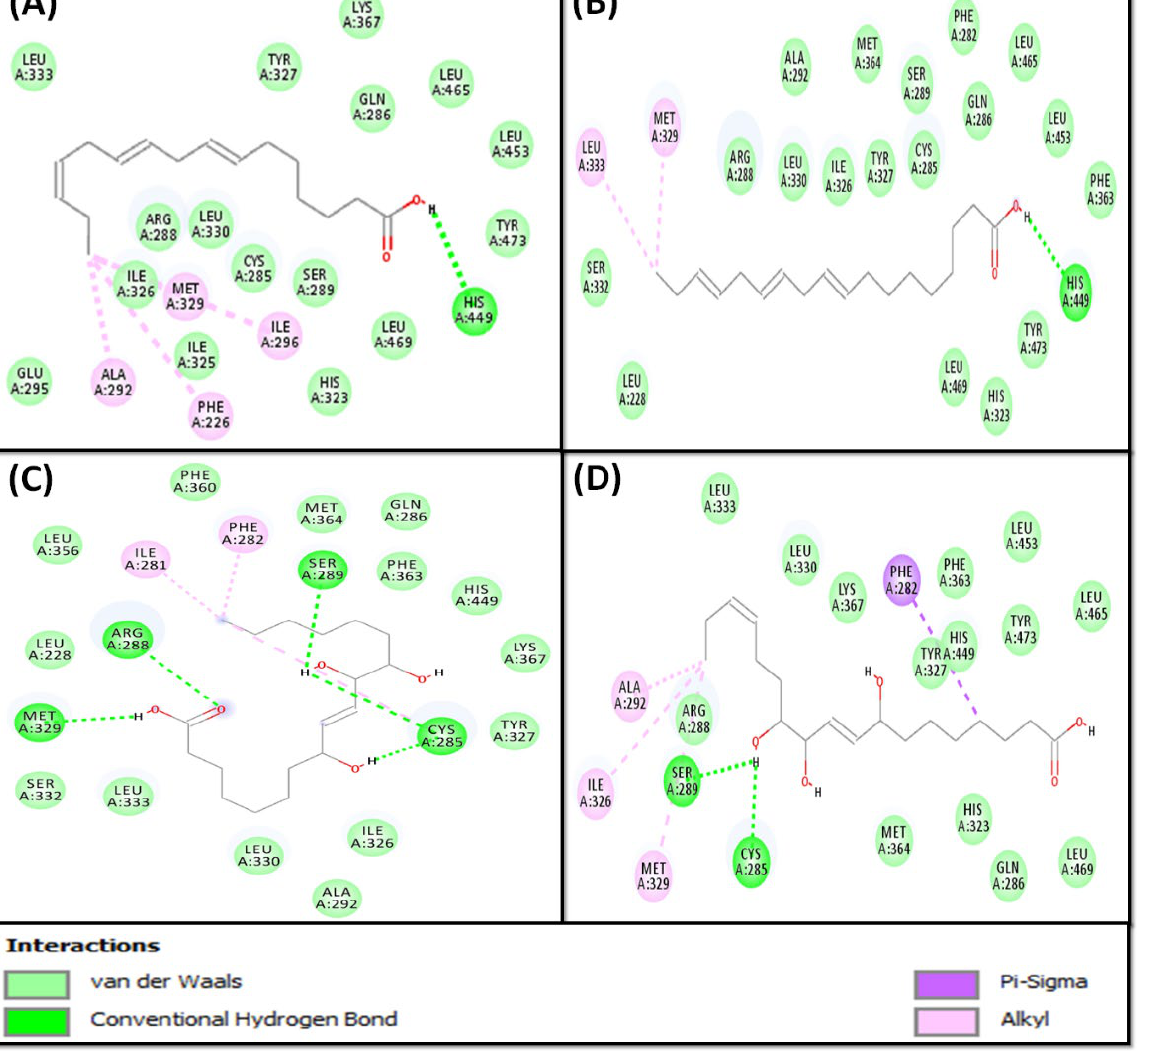
Figure 4. Molecular interaction between isolated SI fatty acids and PPAR- γ. ( A ) Compound 1 , ( B ) compound 2 , ( C ) compound 3 , and ( D ) compound 4 .